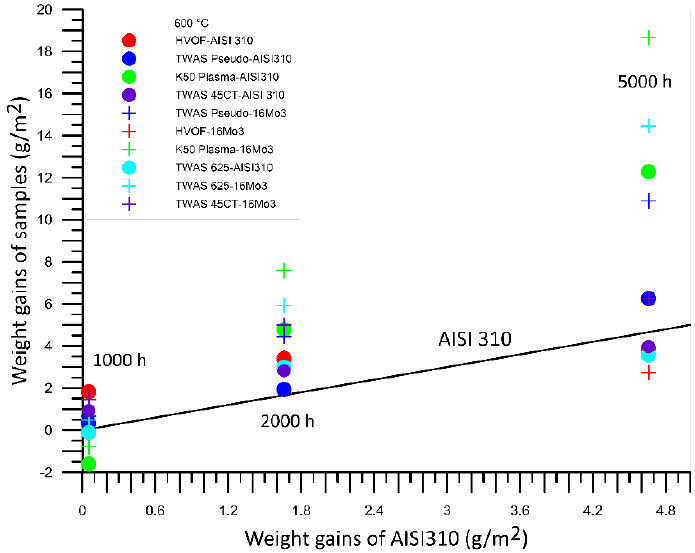
Figure 5. Comparison between the weight gains (determined after the first 500 h of exposure) of AISI 310 and of the samples of various sprayed coatings after exposure at 600 °C.